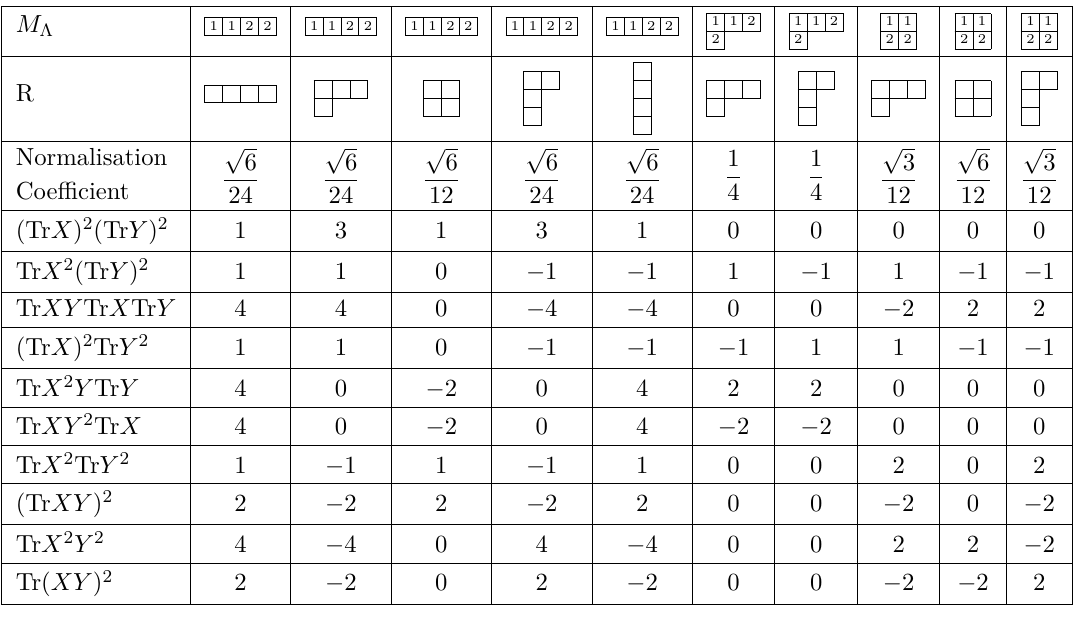
Table 1 . The covariant basis for field content (2 , 2) in terms of multi-traces. Each element is identified by its M and R labels. We give the overall normalisation and the coefficient of each Λ multi-trace within the